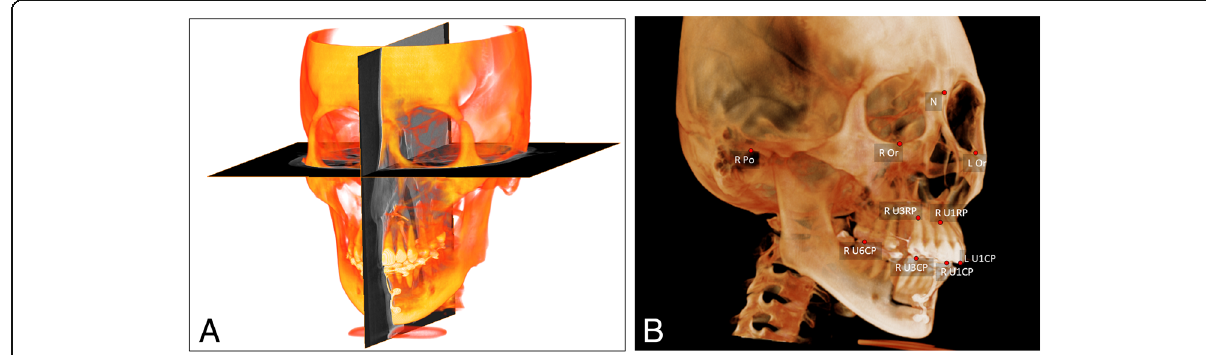
Fig. 2 CBCT orientation ( a ) and 3D coordinates of anterior teeth ( b ). a The XY -plane is parallel to the FH-plane, the YZ -plane is parallel to midsagittal plane (perpendicular to FH plane, including Na-Ba line), and origin point is determined to the nasion. b U1CP (the maxillary central incisal edge point), U1RP(the maxillary central incisors root apex point), U3CP (the maxillary canine cusp point), U3RP(the maxillary canine root apex point), and U6CP (the maxillary first molar mesiobuccal cusp point) were